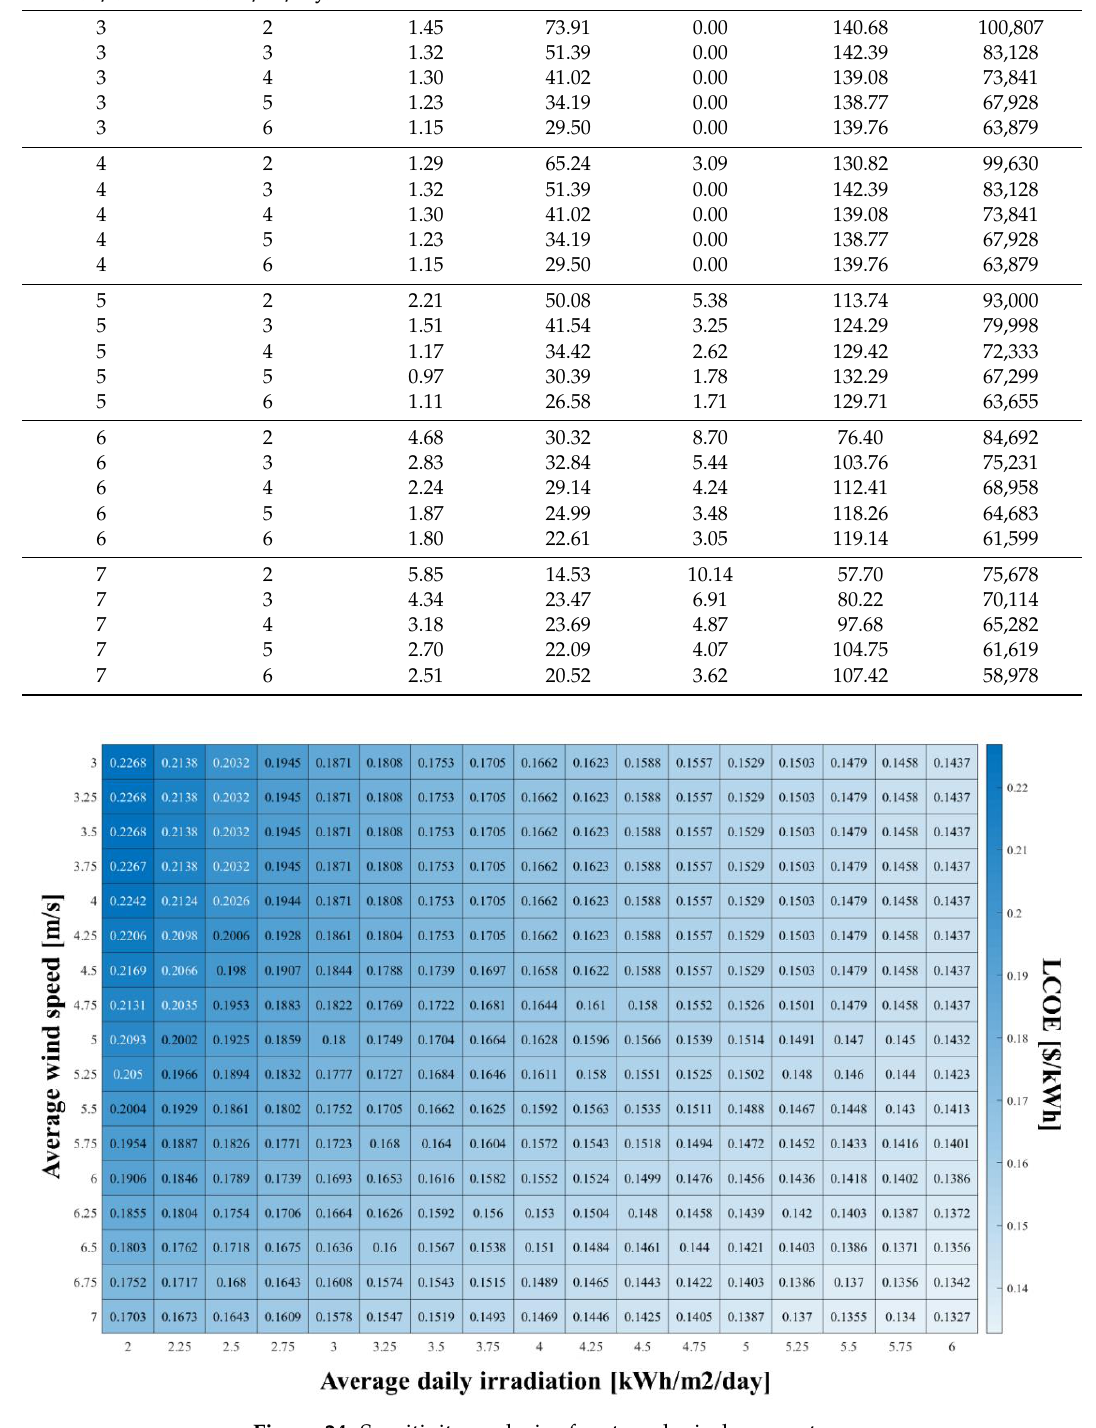
Figure 24. Sensitivity analysis of meteorological parameters.